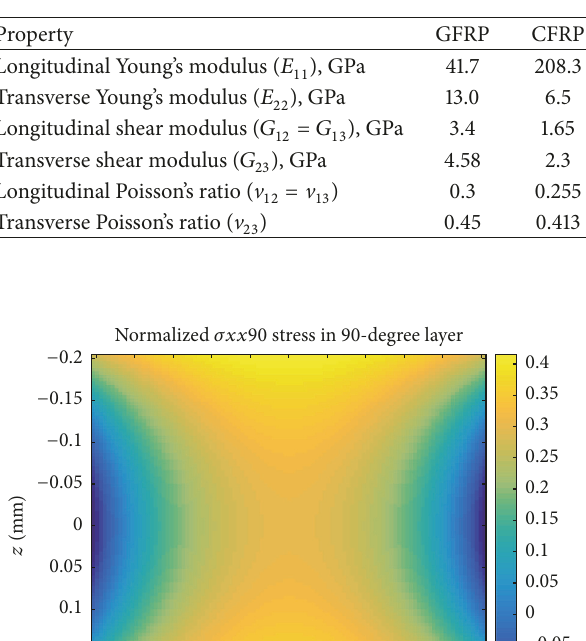
Table 2: Elastic engineering constants for glass-fiber/epoxy and carbon fiber/epoxy composites [5].